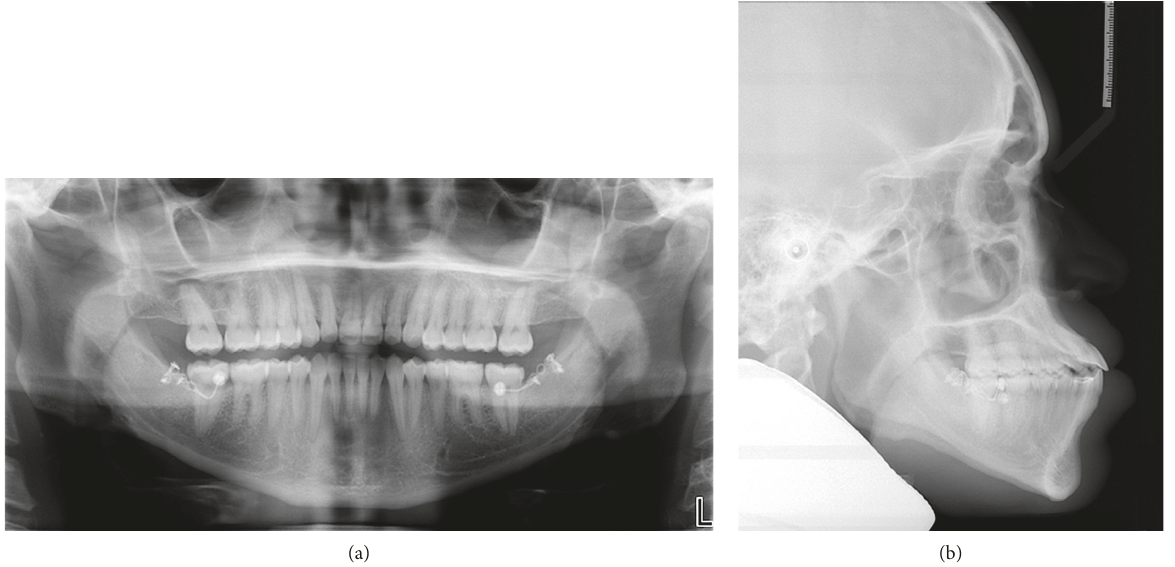
Figure 8: Posttreatment radiographs: (a) panoramic radiograph; (b) lateral cephalograph.